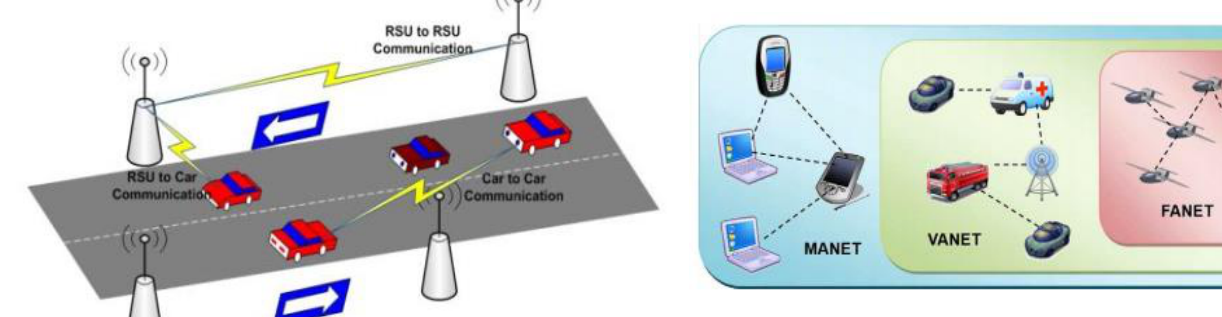
Figure 2 . Architecture of Vehicular ad-hoc network